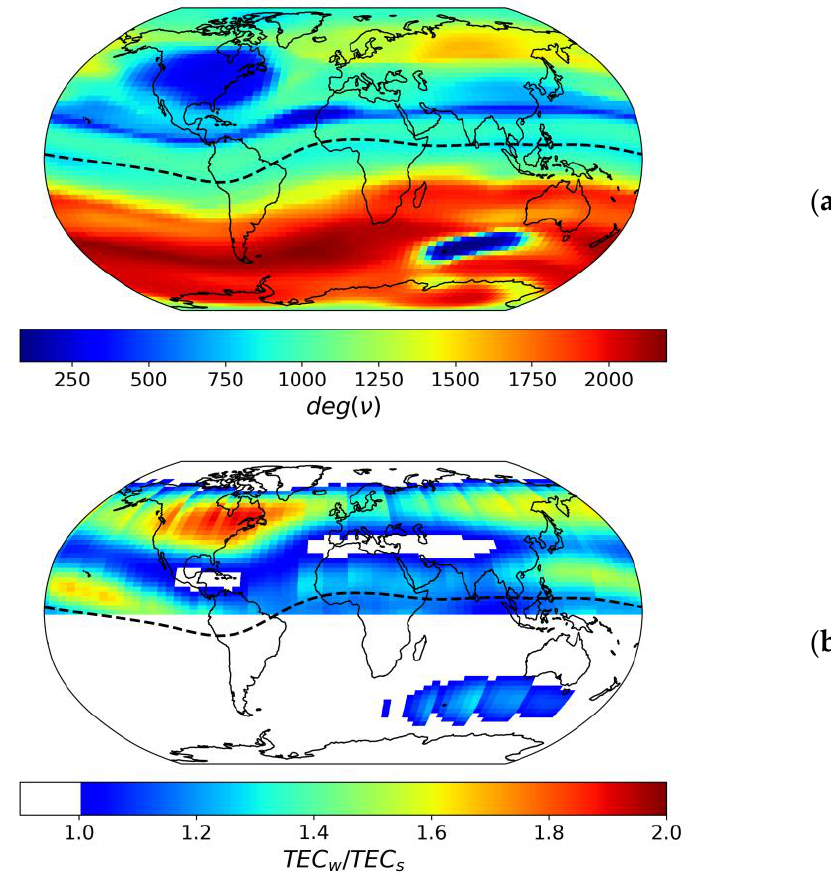
Figure 4. Comparison of ionospheric network based on CODE data ( a ) and the winter anomaly intensity in TEC ( b ). In panel ( a ), color shows the degree ( deg , how many links the node has ) for each node v of the network. In panel ( b ), the color shows the winter anomaly intensity (winter-to-summer TEC) at high solar activity (F10.7 = 200 s.f.u.) and moderate geomagnetic activity. Panel ( b ) was re-drawn from Figure 4f in [31]. Dashed lines show the geomagnetic equator.